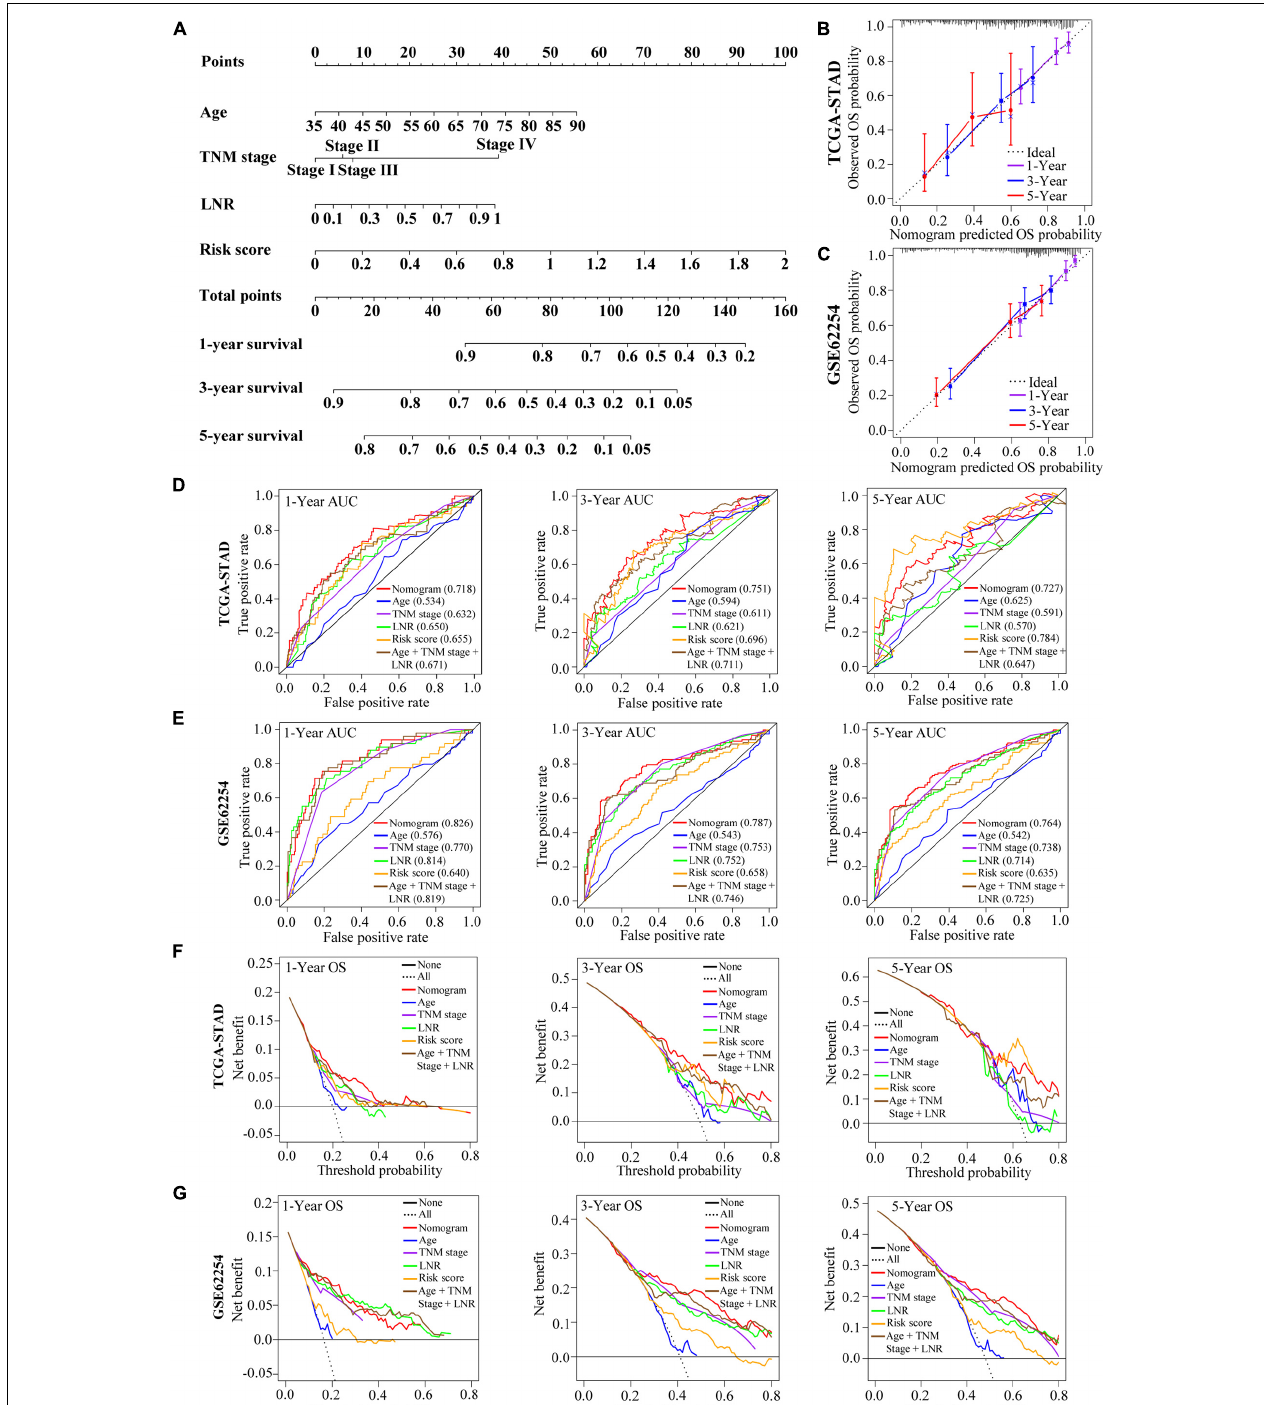
FIGURE 8 | Construction and validation of a nomogram for OS prediction in GC. (A) The nomogram consisting of age, TNM stage, LNR and the risk score. (B,C) Calibration curves of the nomogram for 1-, 3-, and 5-year OS prediction in the TCGA cohort (B) and the GEO cohort (C) . The X-axis represents the nomogram-predicted outcome while Y-axis represents the observed outcome. The 45 ◦ line represents the best prediction. (D,E) Time-dependent ROC curves of the nomogram, age, TNM stage, LNR, risk score and age + TNM stage + LNR model for 1-, 3-, and 5-year OS prediction in the TCGA cohort (D) and the GEO cohort (E) . (F,G) DCA curves of the nomogram, age, TNM stage, LNR, risk score and age + TNM stage + LNR model for 1-, 3-, and 5-year OS prediction in the TCGA cohort (F) and the GEO cohort (G) . The plots show the expected net benefits at different threshold probability. The black line “None” represents the assumption that event will happen in no patients while the dash line “All” represents the assumption that event will happen in all patients.